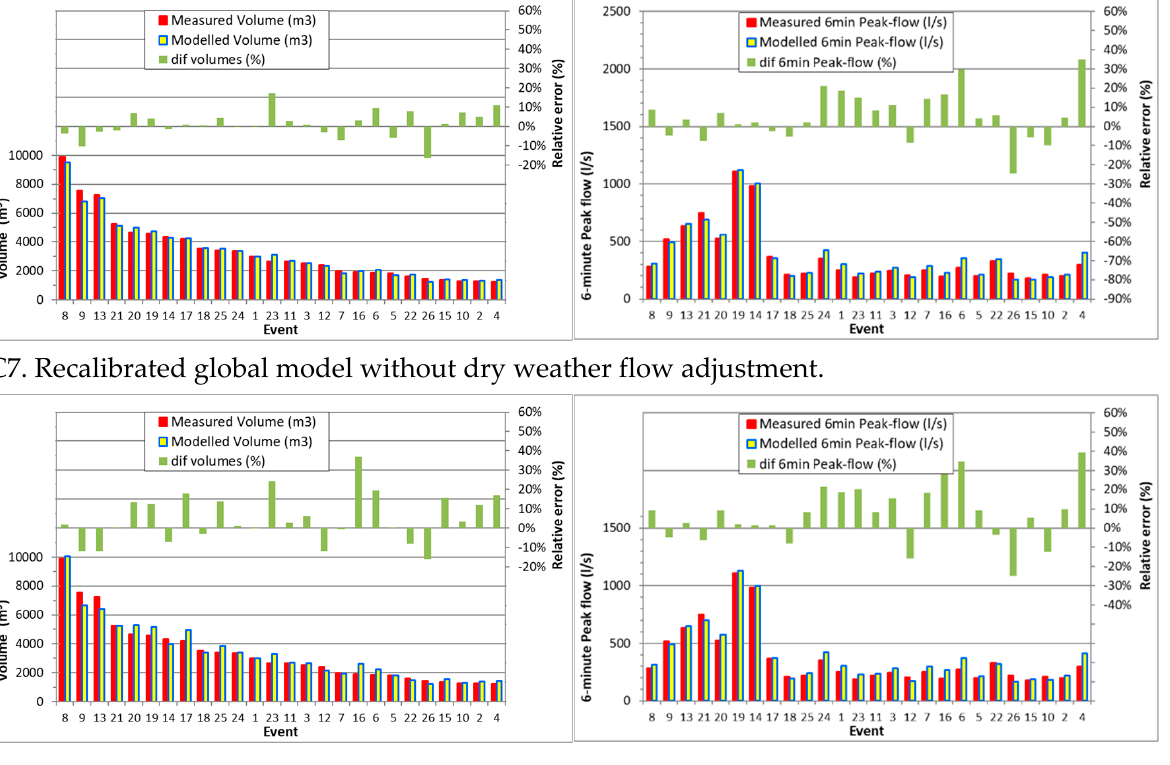
Figure 6. Graphical results for volume and 6-min peak flow of the recalibrated model in monitoring section B1-M . section